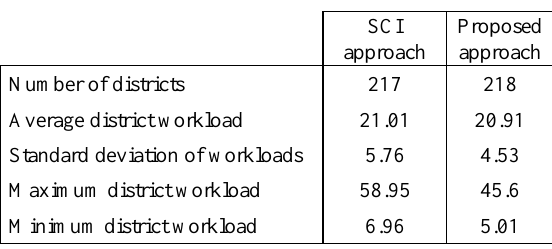
Table 2. Statistical comparison of the workloads